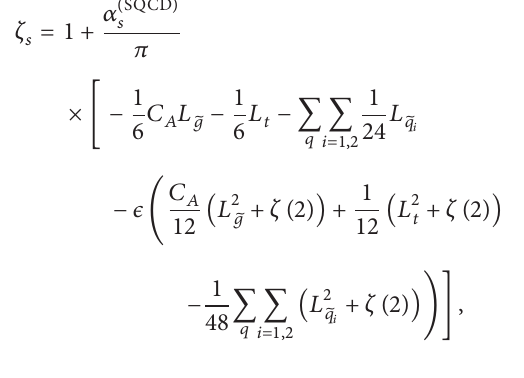
Figure 5: Sample diagrams contributing to 𝜁 3 , and gluinos ( ̃𝑔